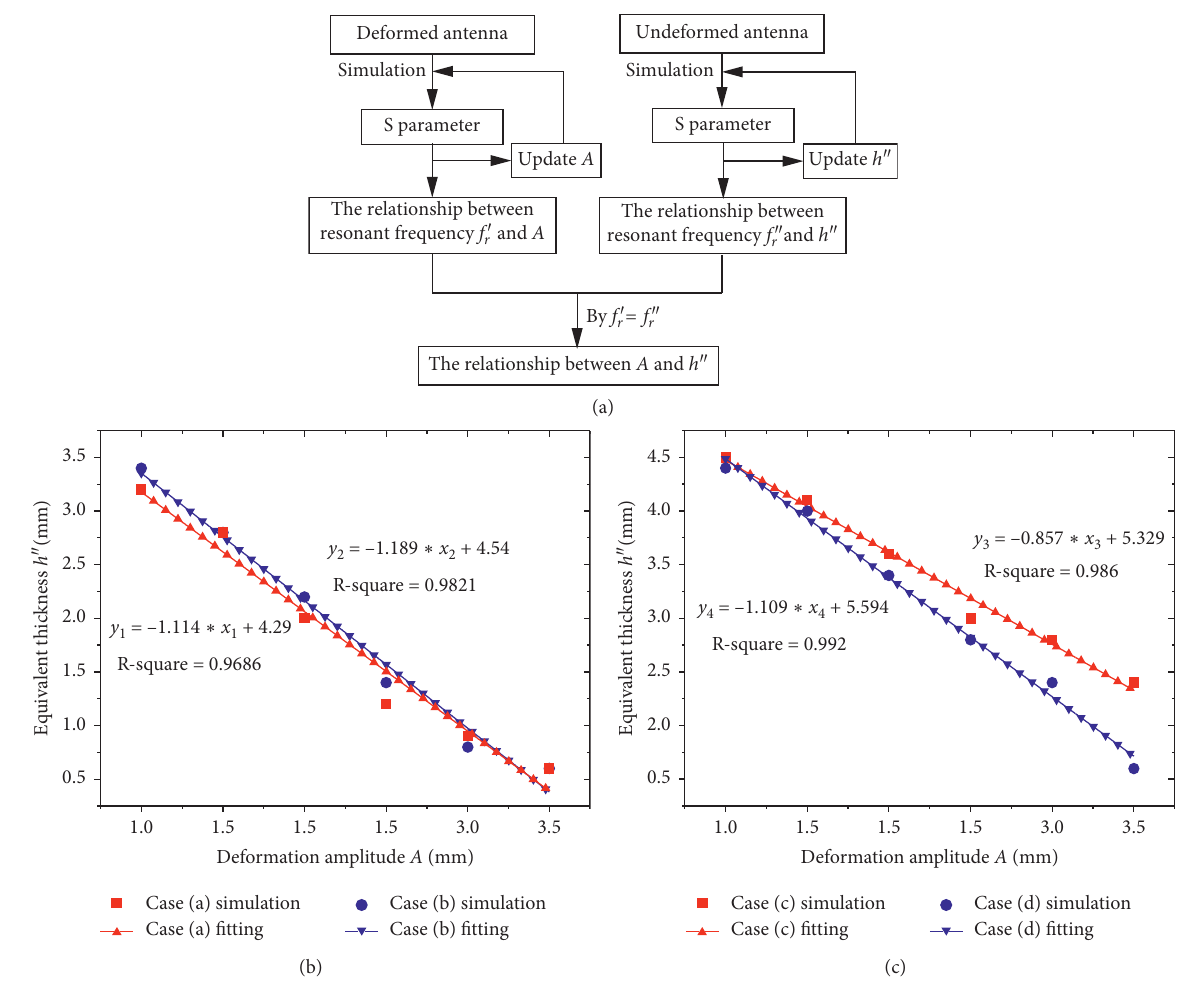
Figure 7: Relationship between deformation amplitude A and equivalent thickness h ″ . The (a) equivalent thickness illustration, (b) XOZ plane deformation, and (c) YOZ plane